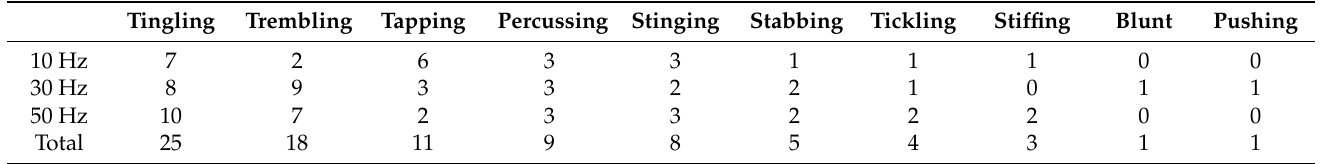
Table 1. Subjective evaluation results of magnetic field stimulation at three different frequencies. The number indicates the number of subjects who selected the word.